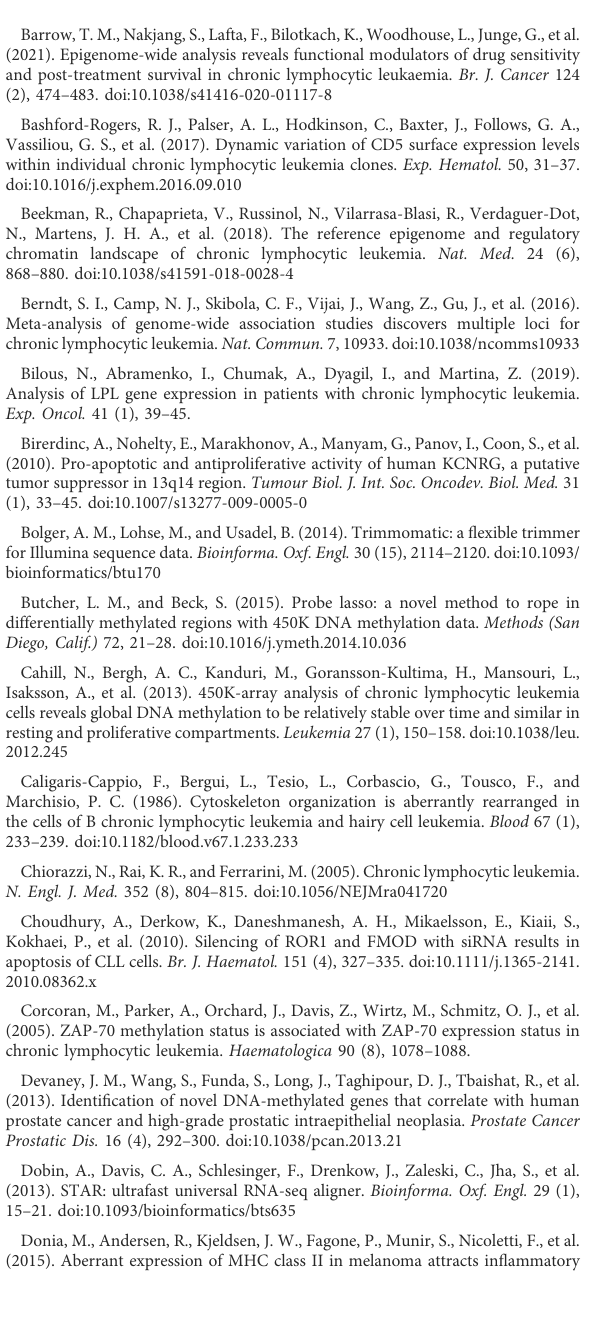
SUPPLEMENTARY TABLE S8 (A) DMEGs with DMPs in body regions all positive with expression (N = 335). (B) DMEGs with DMPs in body regions all negative with expression (N = 326). (C) DMEGs with DMPs in promoter regions all negative with expression (N = 225). (D) DMEGs with DMPs both in promoter and body regions all negative with expression (N = 83). (E) DMEGs with DMPs in promoter negative and body regions positive with expression (N =